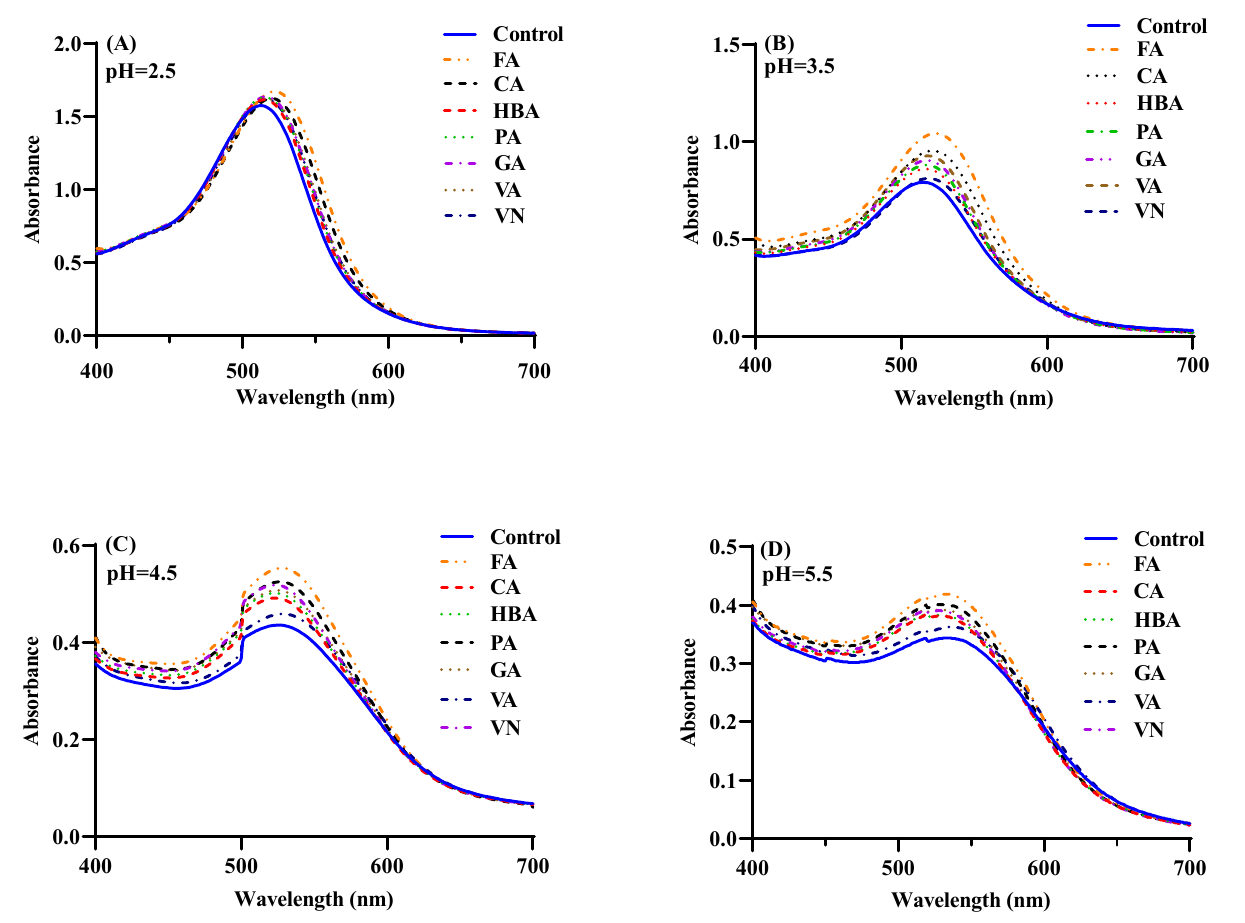
Figure 4. Visible absorption spectra of the mulberry anthocyanin co-pigmentation with co-pigments (1:20, 20 ◦ C) at different pH value ( A – D